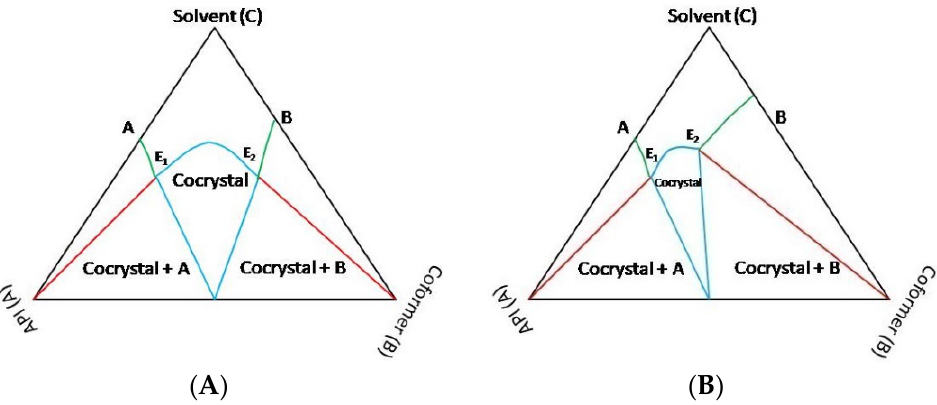
Figure 9. ( A ) Schematic representation of ( A ) a symmetric ternary phase diagram and ( B ) an asymmetric ternary phase diagram [A—API; B—Coformer, C—Solvent, E 1 and E 2 —Eutectic points] [148].